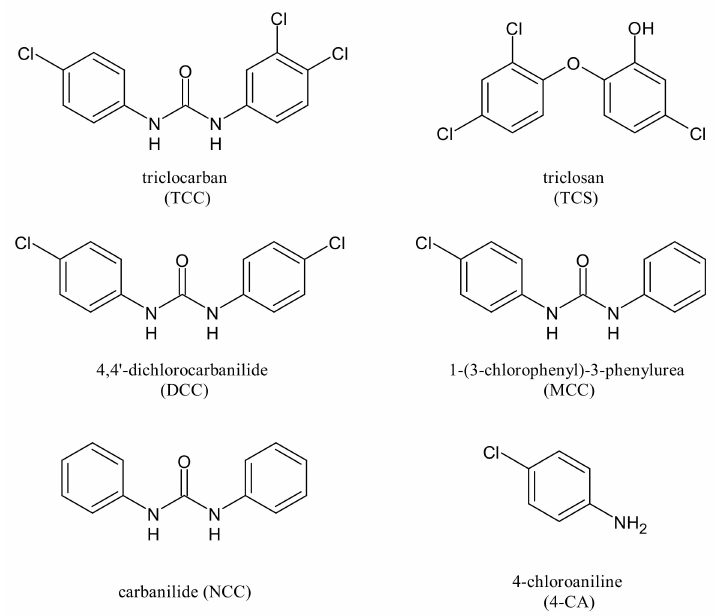
Figure 1. Triclocarban (TCC), triclosan and TCC transformation